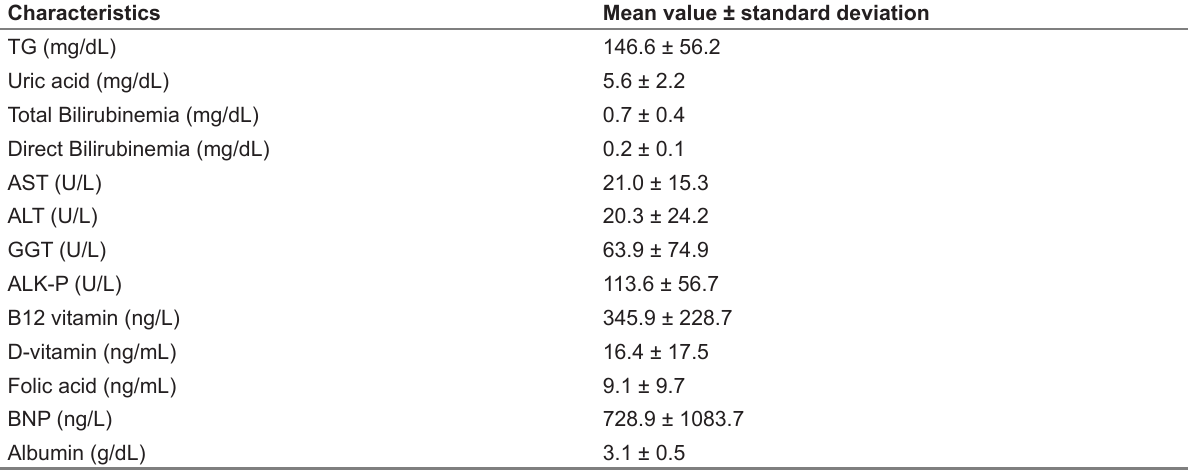
Table 2. Biochemical assays of the 75 patients admitted in the Diabetic Foot Unit ( continued ) Characteristics